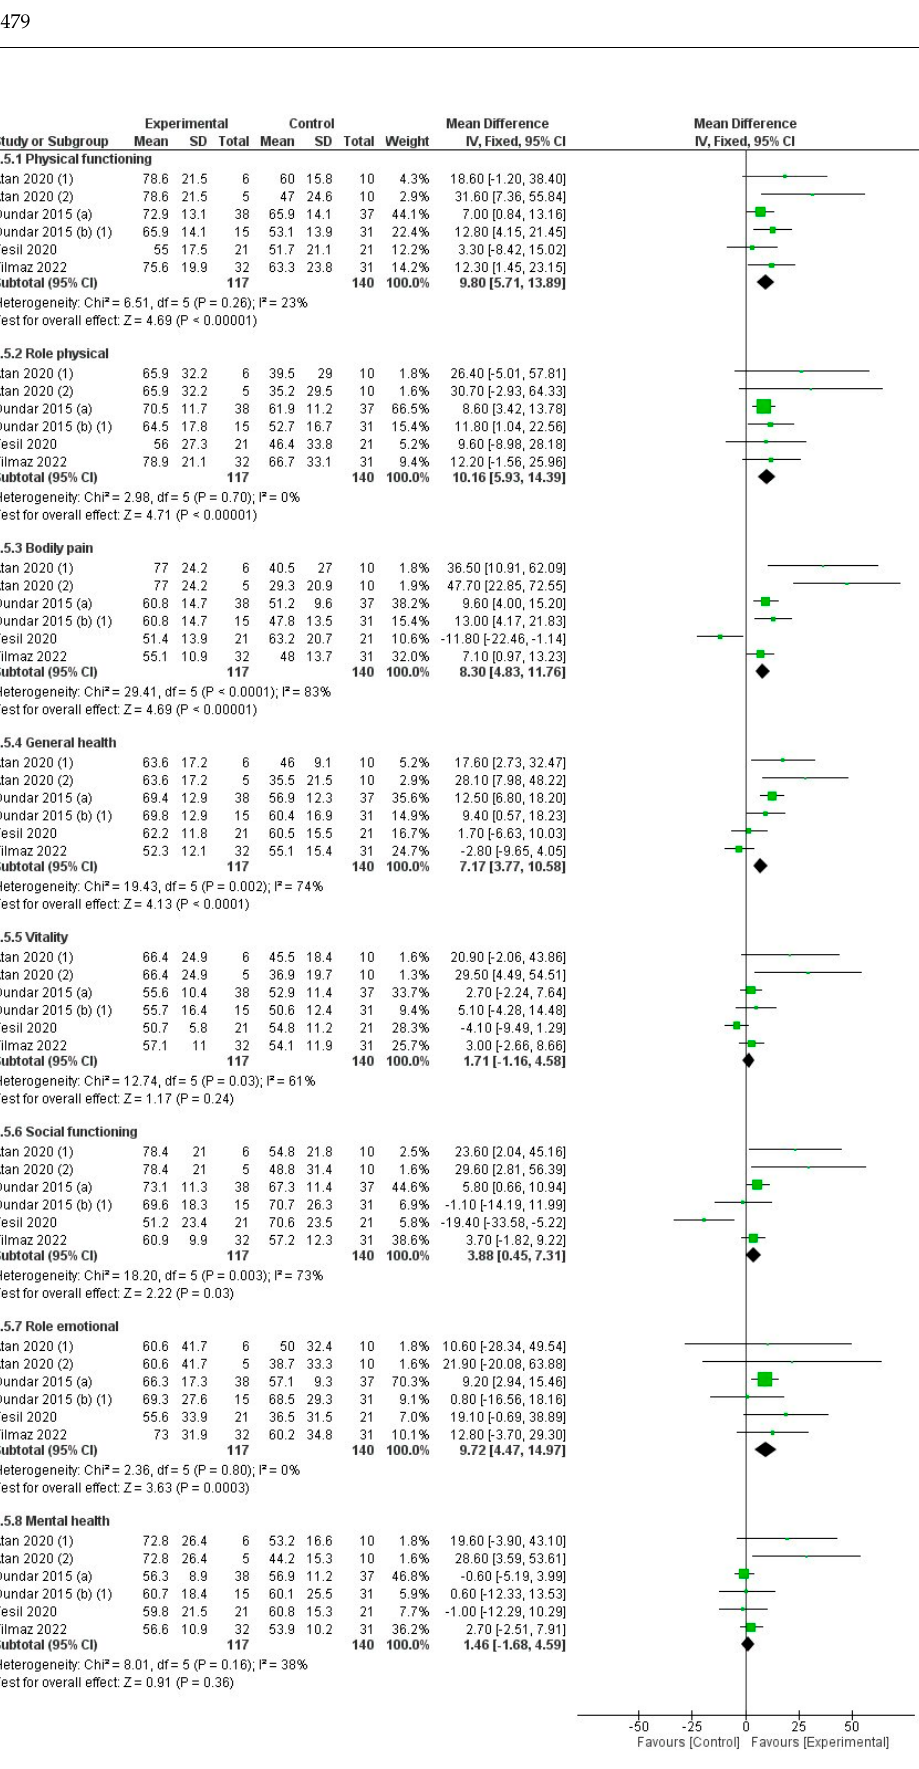
Figure 7. Forest plot for the overall effect on quality-of-life assessment by SF-36 questionary comparing high-intensity laser therapy (HILT) vs. control .